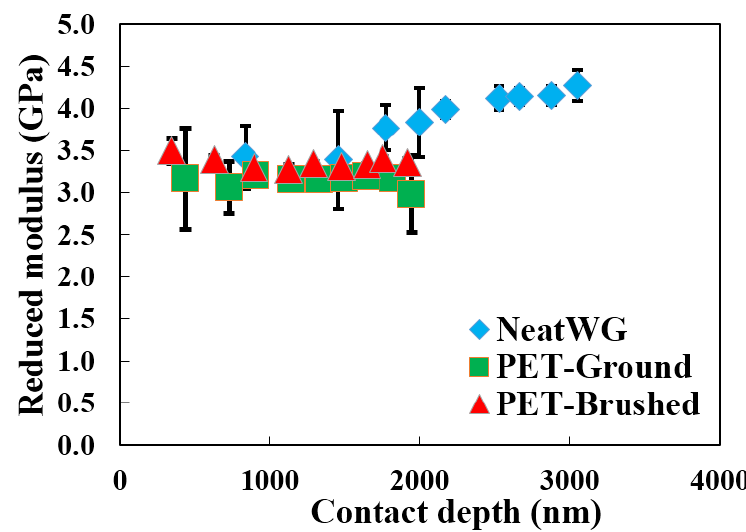
Figure 3. Reduced nanoindentation modulus measured top-down.